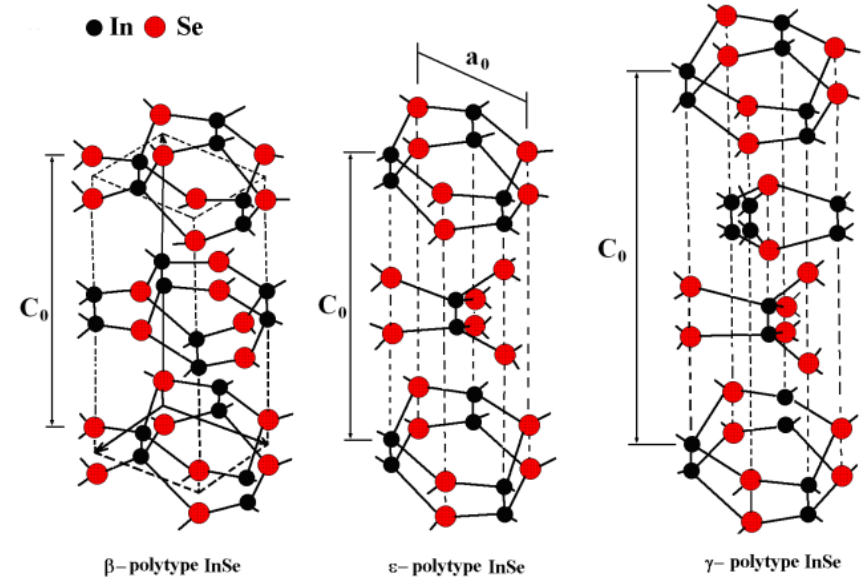
Figure 1. Geometrical structure of the three polytypes of InSe. C 0 and a 0 represent the lattice parameters along the perpendicular to layers and in the layer plane, respectively. Reproduced from Ref. [39].